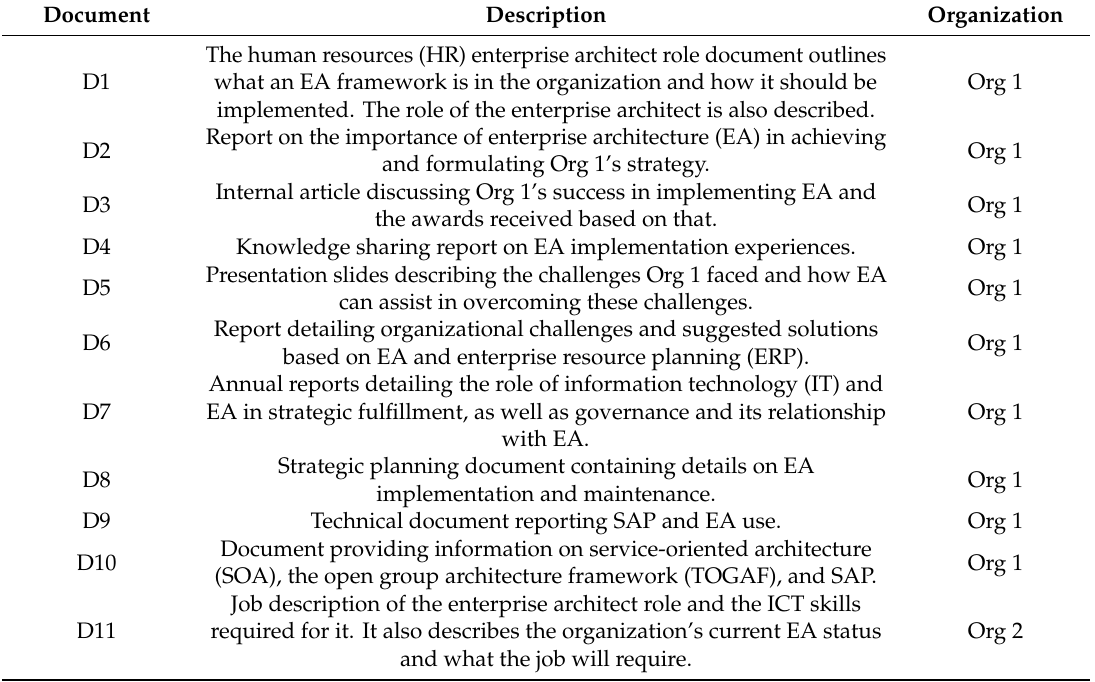
Table 4. Documents collected in phase